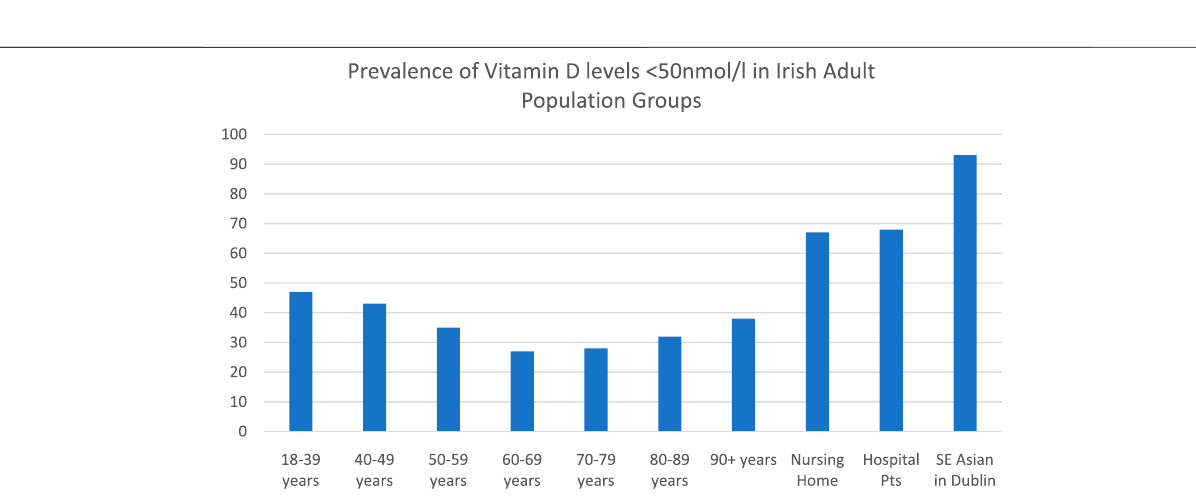
Frontiers in Pharmacology |